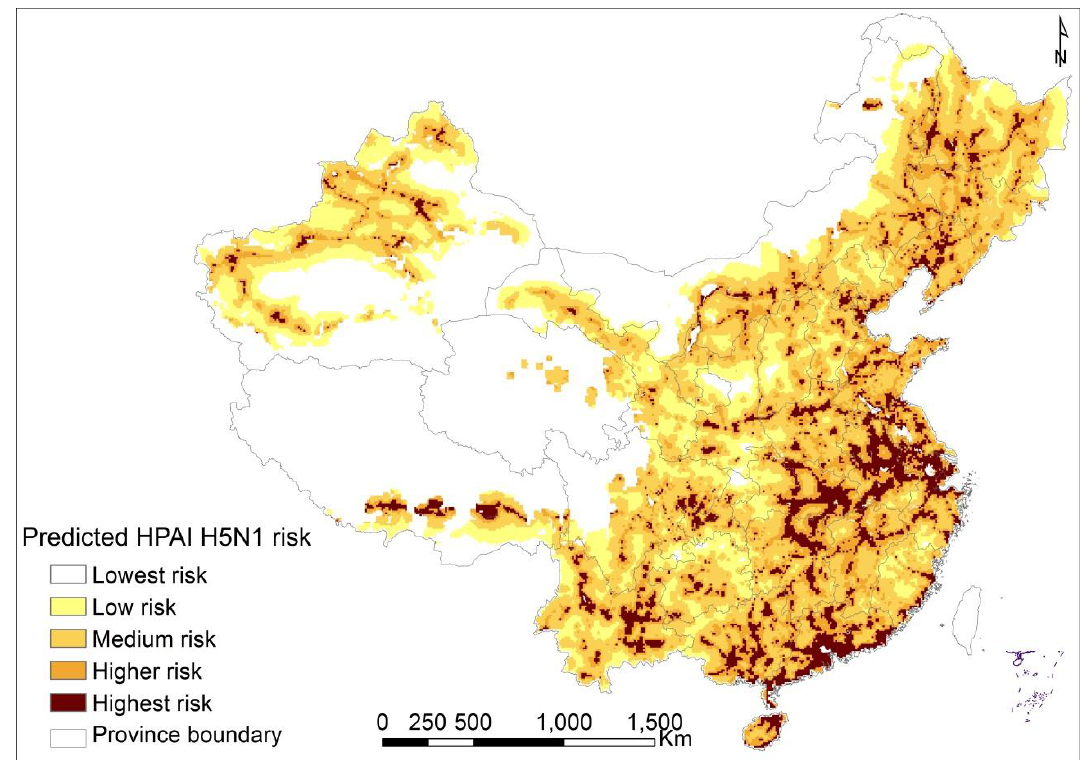
Figure 4. Predictive risk of HPAI H5N1 outbreaks in domestic poultry in mainland China; The predictive risk map shows increased risk of HPAI H5N1 outbreaks in domestic poultry with color